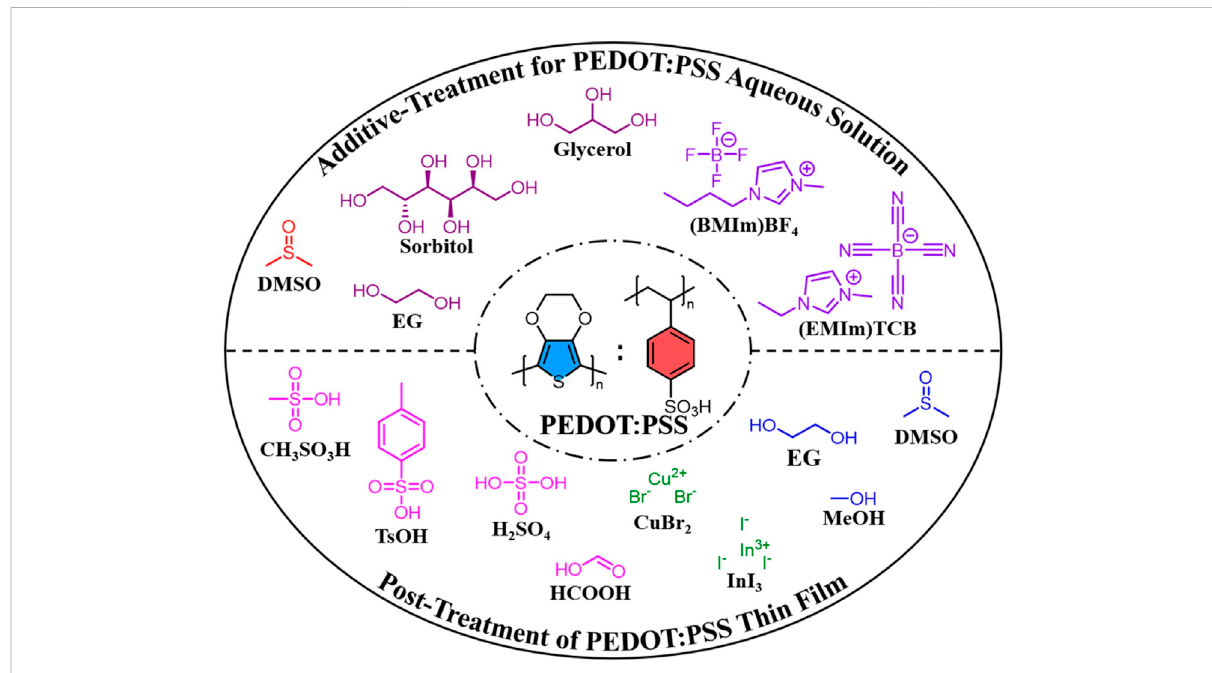
FIGURE 2 Modi fi cation of PEDOT:PSS thin fi lms based on additive-treatment for PEDOT:PSS aqueous solution and post-treatment of PEDOT:PSS thin fi lm in green